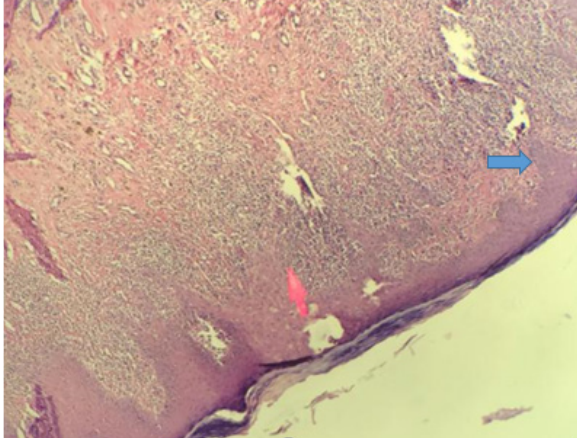
Figure 1. Lichenoid infiltration and hydropic degeneration of basal cells (pink arrow), saw tooth hyperplasia of rete ridges (blue arrow) in cutaneous LP (magnification ×100). Note . LP: Lichen planus.